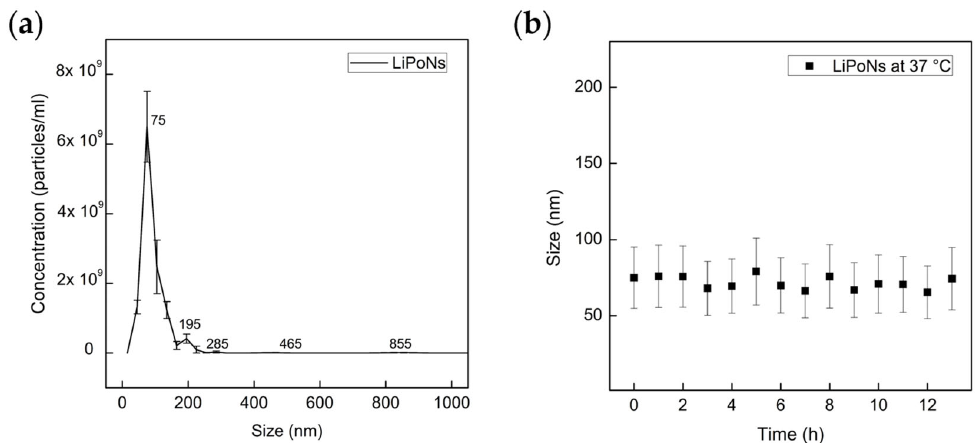
Figure 4. Physical Stability Study of LiPoNs: ( a ) particle size distribution is expressed as the average and standard error of the mean LiPoNs’ concentration (particles/mL) evaluated in PBS (diluted 1:200) for five measurements; ( b ) LiPoNs’ average size and standard deviation observed at 37 °C for several time points (up to 13 h).